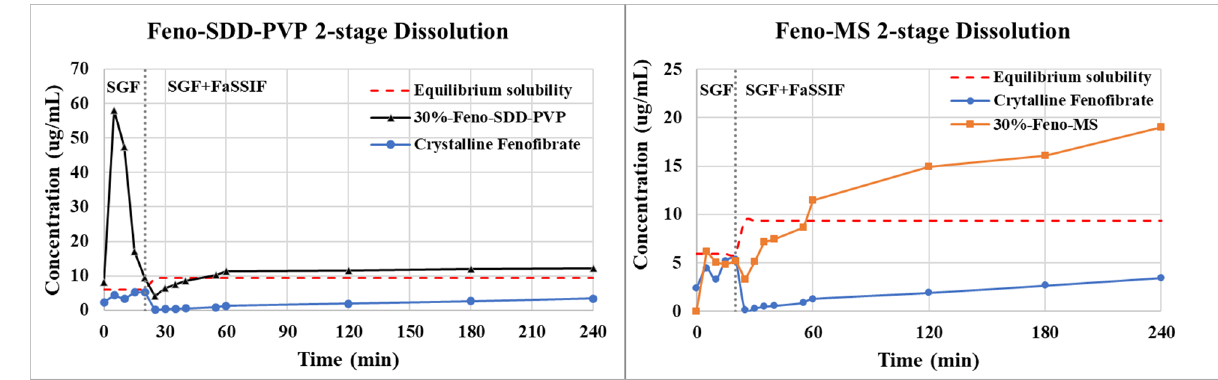
Figure 8. The 2-stage dissolution profiles of 30%-Feno-SDD-PVP and 30%-Feno-MS with crystalline fenofibrate as the reference. SGF stage: 0–20 min; SGF + FaSSIF stage: 20–240 min.